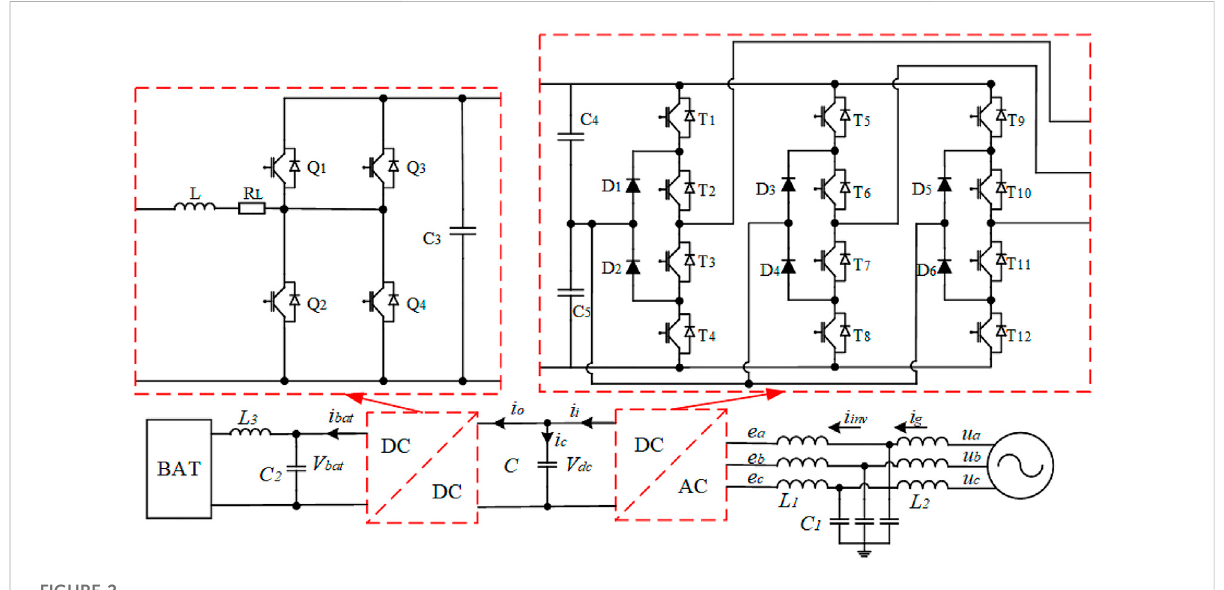
FIGURE 2 Equipment circuit